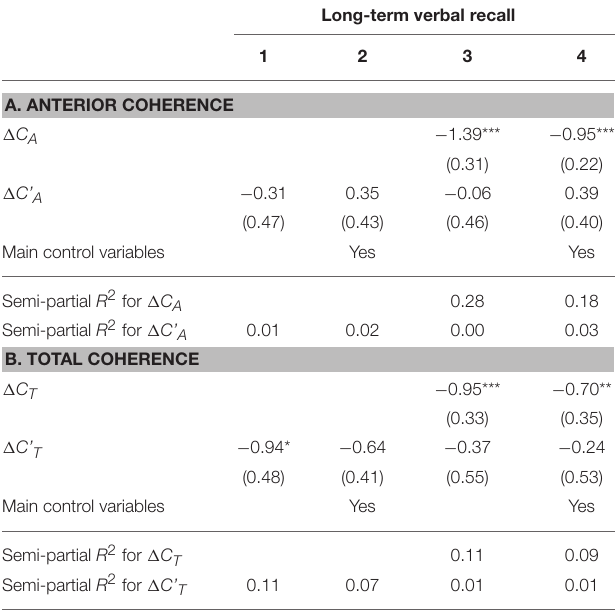
TABLE 10 | Analysis with auditory explanatory